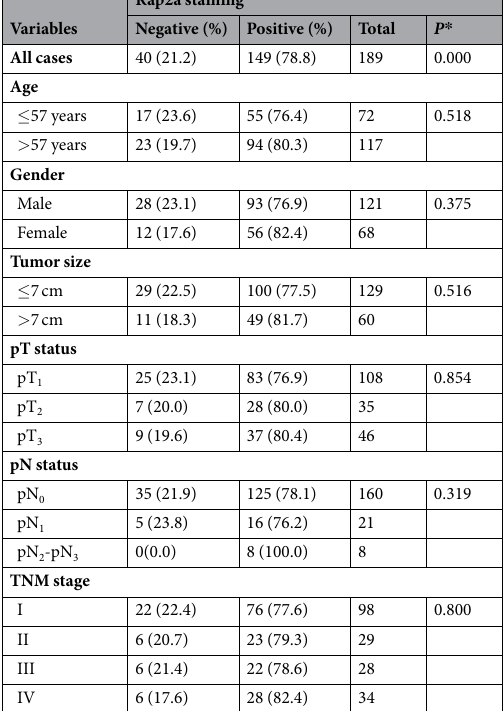
Table 1. Patients characteristics and Rap2a expression. * P values are obtained from χ 2